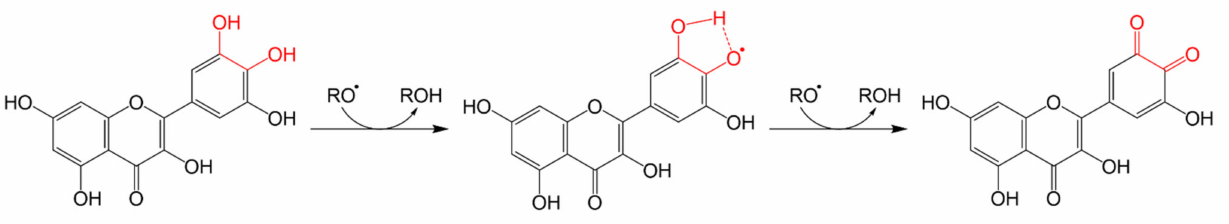
Figure 3. Scavenging of ROS by flavonoids, myricetin neutralizing free radicals, and scavenging of ROS by C3 (cid:48) and C4 (cid:48) or C4 (cid:48) and C5 (cid:48)